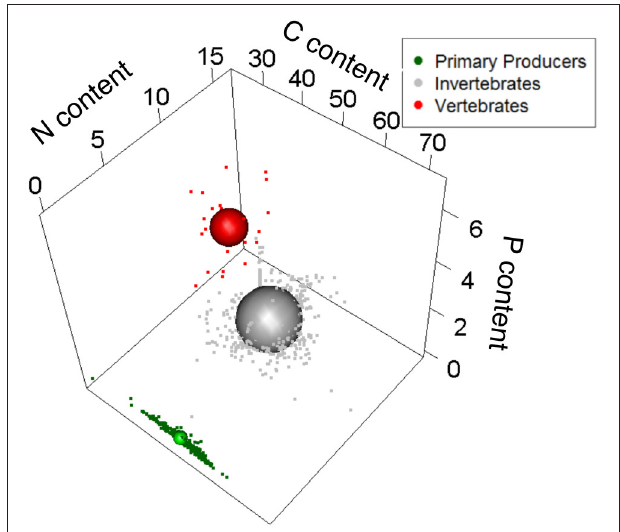
FIGURE 1 | Relative size of stoichiometric niche volumes of primary producers, invertebrates, and vertebrates (combining multiple terrestrial and aquatic food webs from bromeliads). Sphere sizes depicts the volumes of the stoichiometric niches, and are centered around the average C, N, and P contents of all individuals from those variables. Dots are individual coordinates and show the variability within a given stoichiometric niche. Axes represent each element as a percentage of dry body